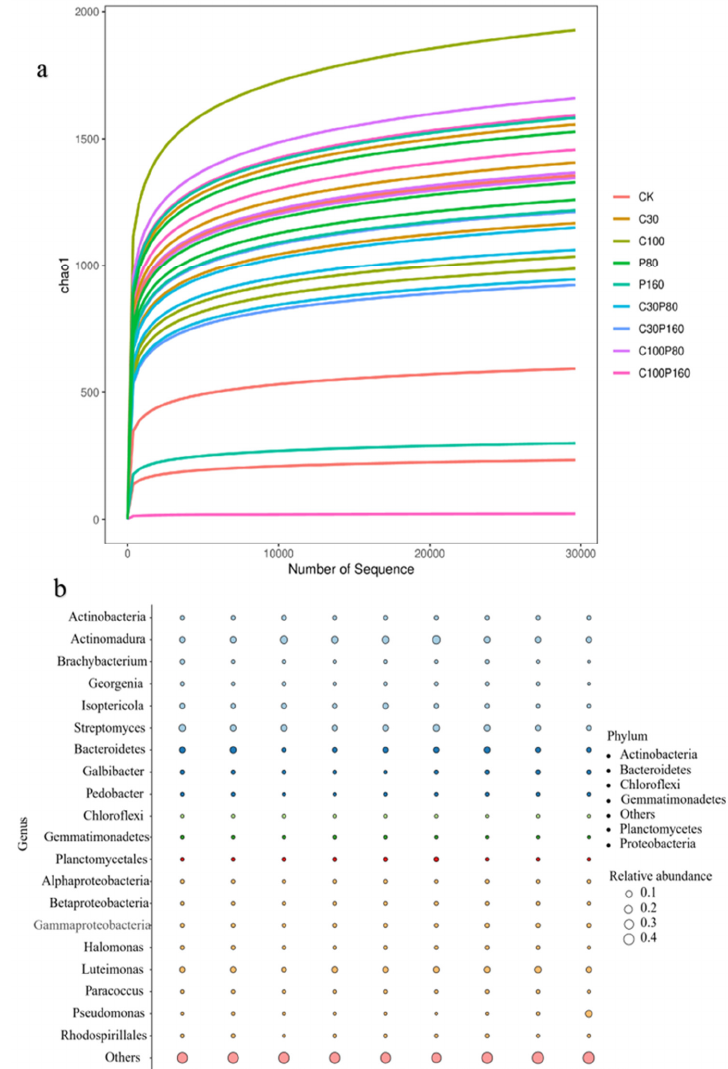
Figure 2. ( a ) Rarefaction curve; ( b ) the bubble plot uses the size and color changes of bubbles to directly reflect the data information of bacterial species annotation and abundant two-dimensional matrix.